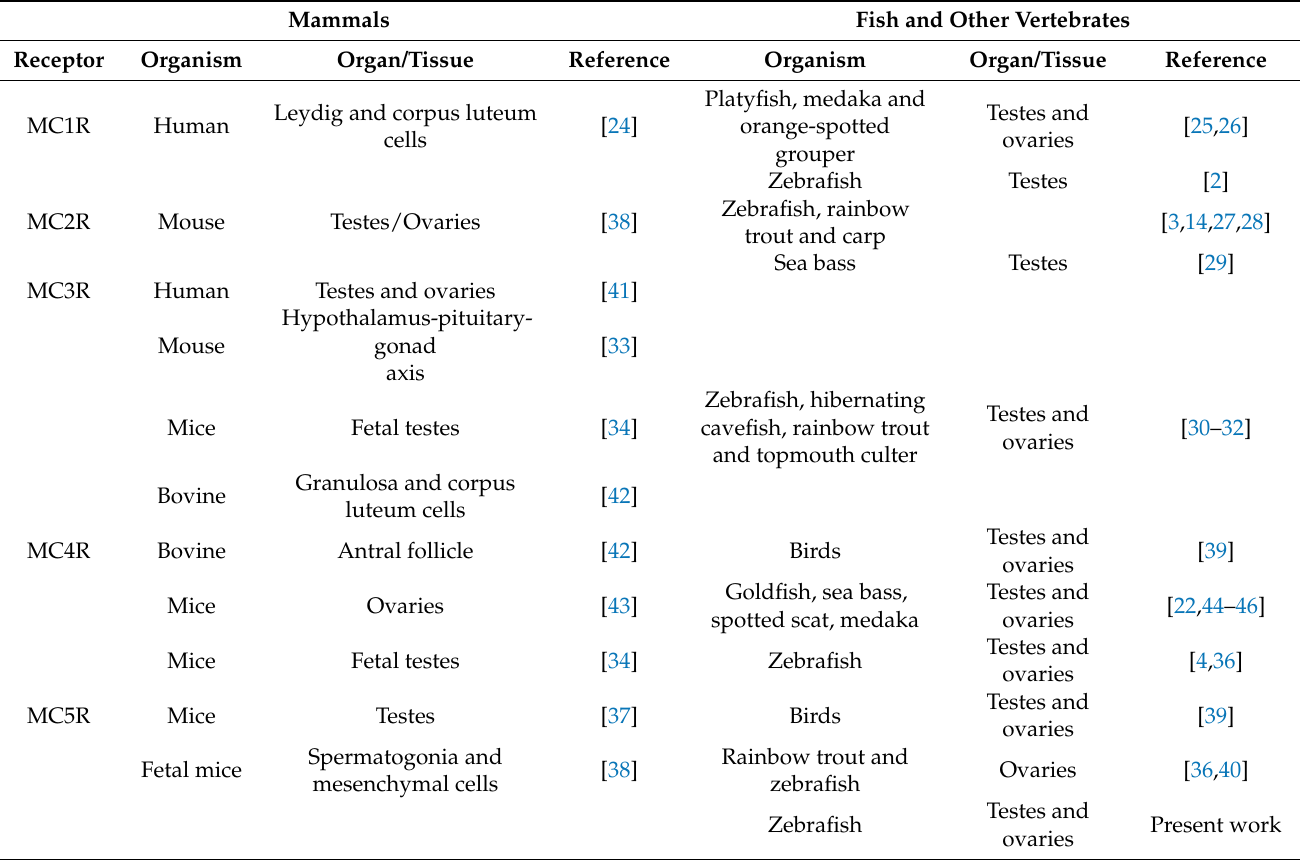
Table 2. Melanocortin receptor expression in different organ/tissues of several